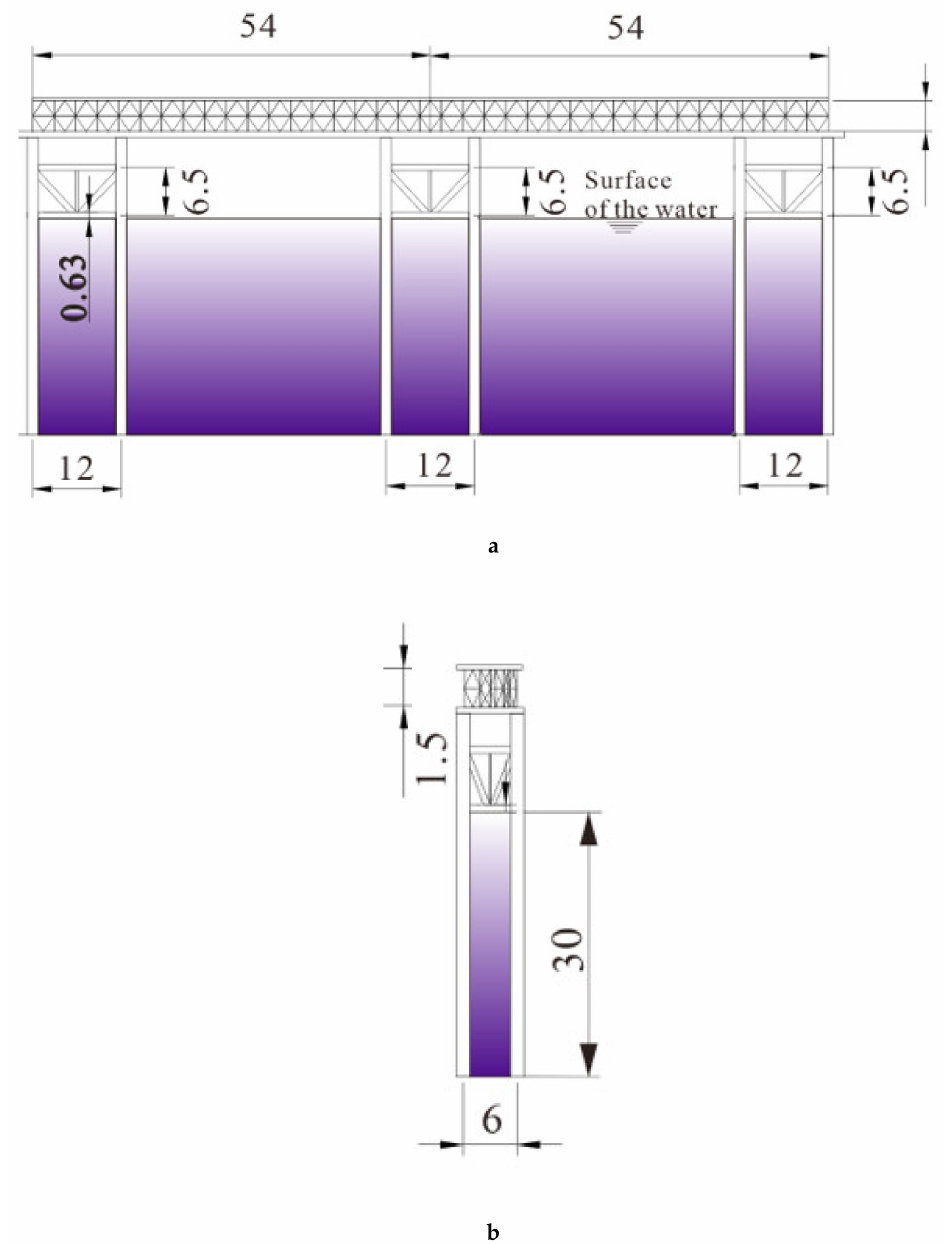
Figure 6. Sectional views of the example OST (unit (m)): ( a ) Elevation view; ( b ) side